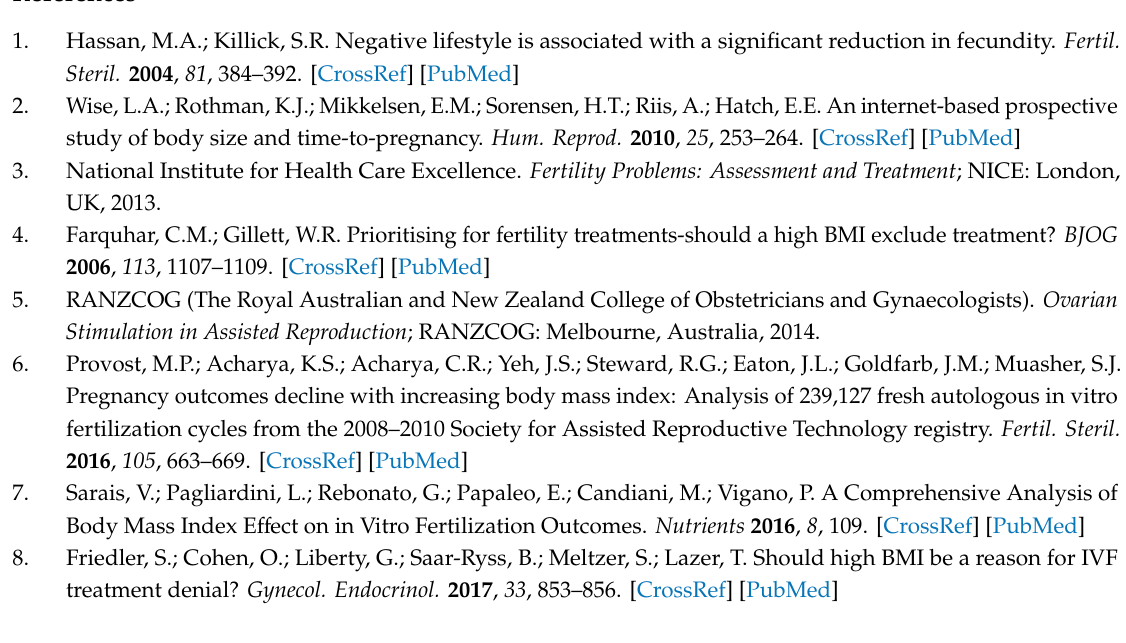
Table S1: Median rank of embryo transfer to obtain a first live birth; Table S2: Percentages of women with at least one fresh and / or frozen embryo transfer that resulted in live birth by cycle and BMI class; Table S3: Adjusted odd ratios for miscarriage at the first clinical pregnancy by cycle and BMI